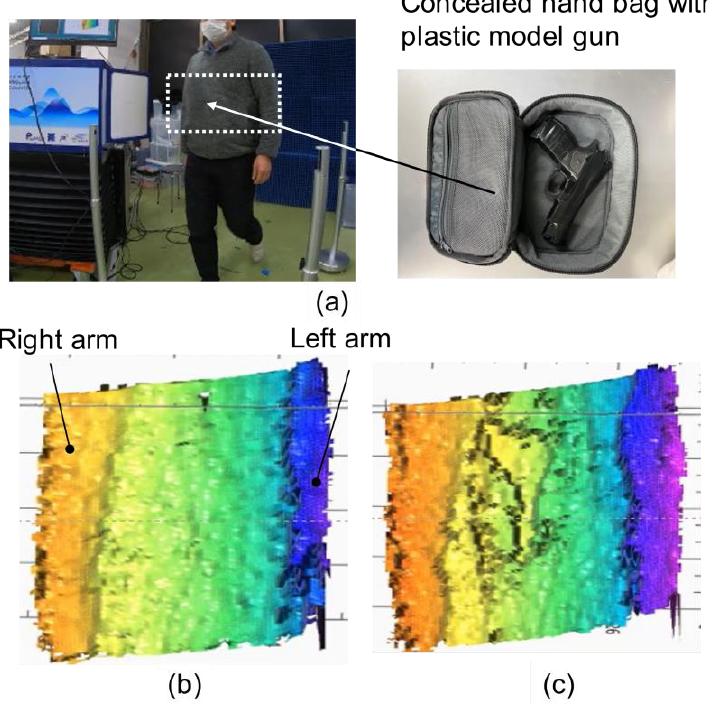
Figure 15. ( a ) Target scenario of a pedestrian concealing a handbag containing a model gun. ( b , c ) 3D reconstruction images of a pedestrian with and without handbag containing a plastic model gun.